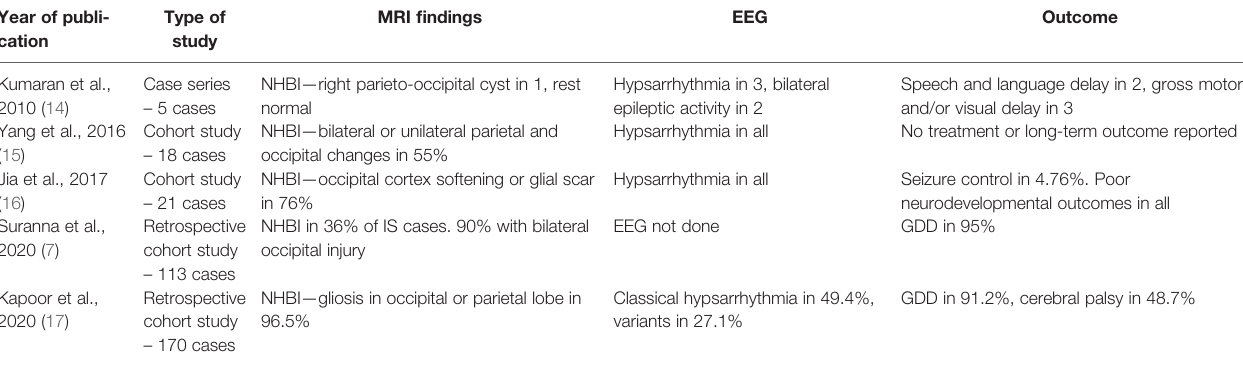
TABLE 1 | A summary of cohort studies of infants with neonatal hypoglycemic brain injury, infantile spasms, and neurodevelopmental